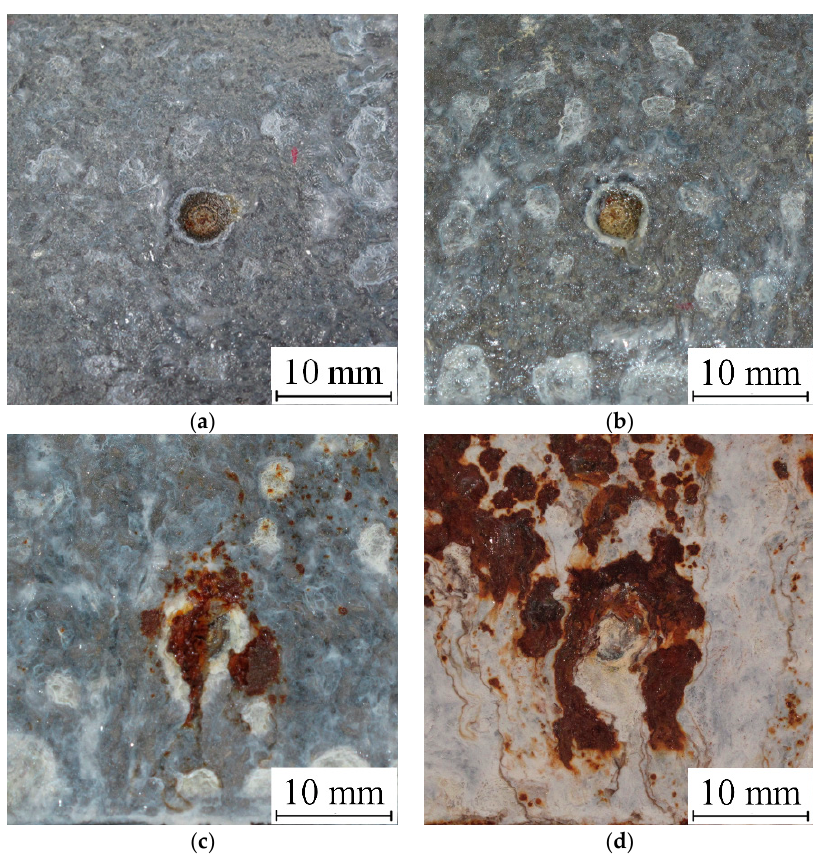
Figure 7. State of corrosion on the external surfaces of the spot welds during the salt spray corrosion test after the following exposure times: ( a ) 24 h, ( b ) 48 h, ( c ) 168 h, and ( d ) 500 h. Images obtained from a sample welded with run no. 4.